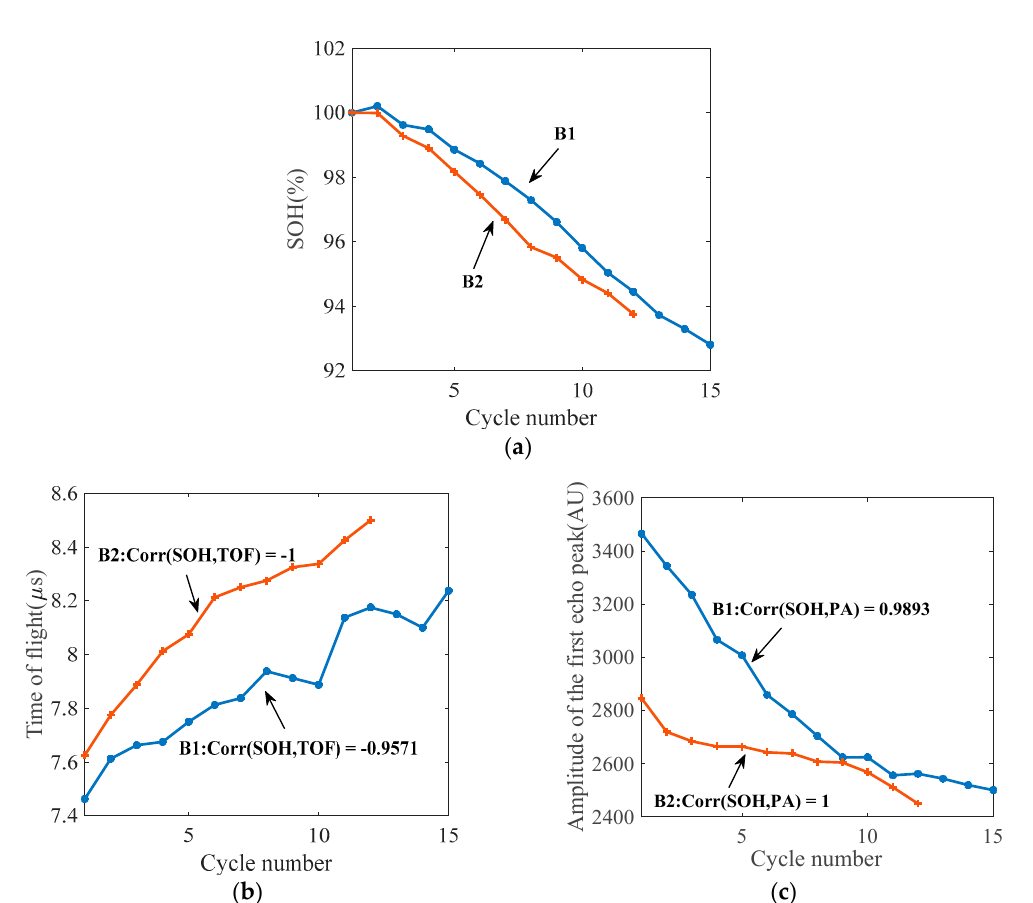
Figure 5. Cycling test results for batteries B1 and B2: ( a ) cycling performance, ( b ) time-of-flight, ( c ) amplitude of the first echo peak.